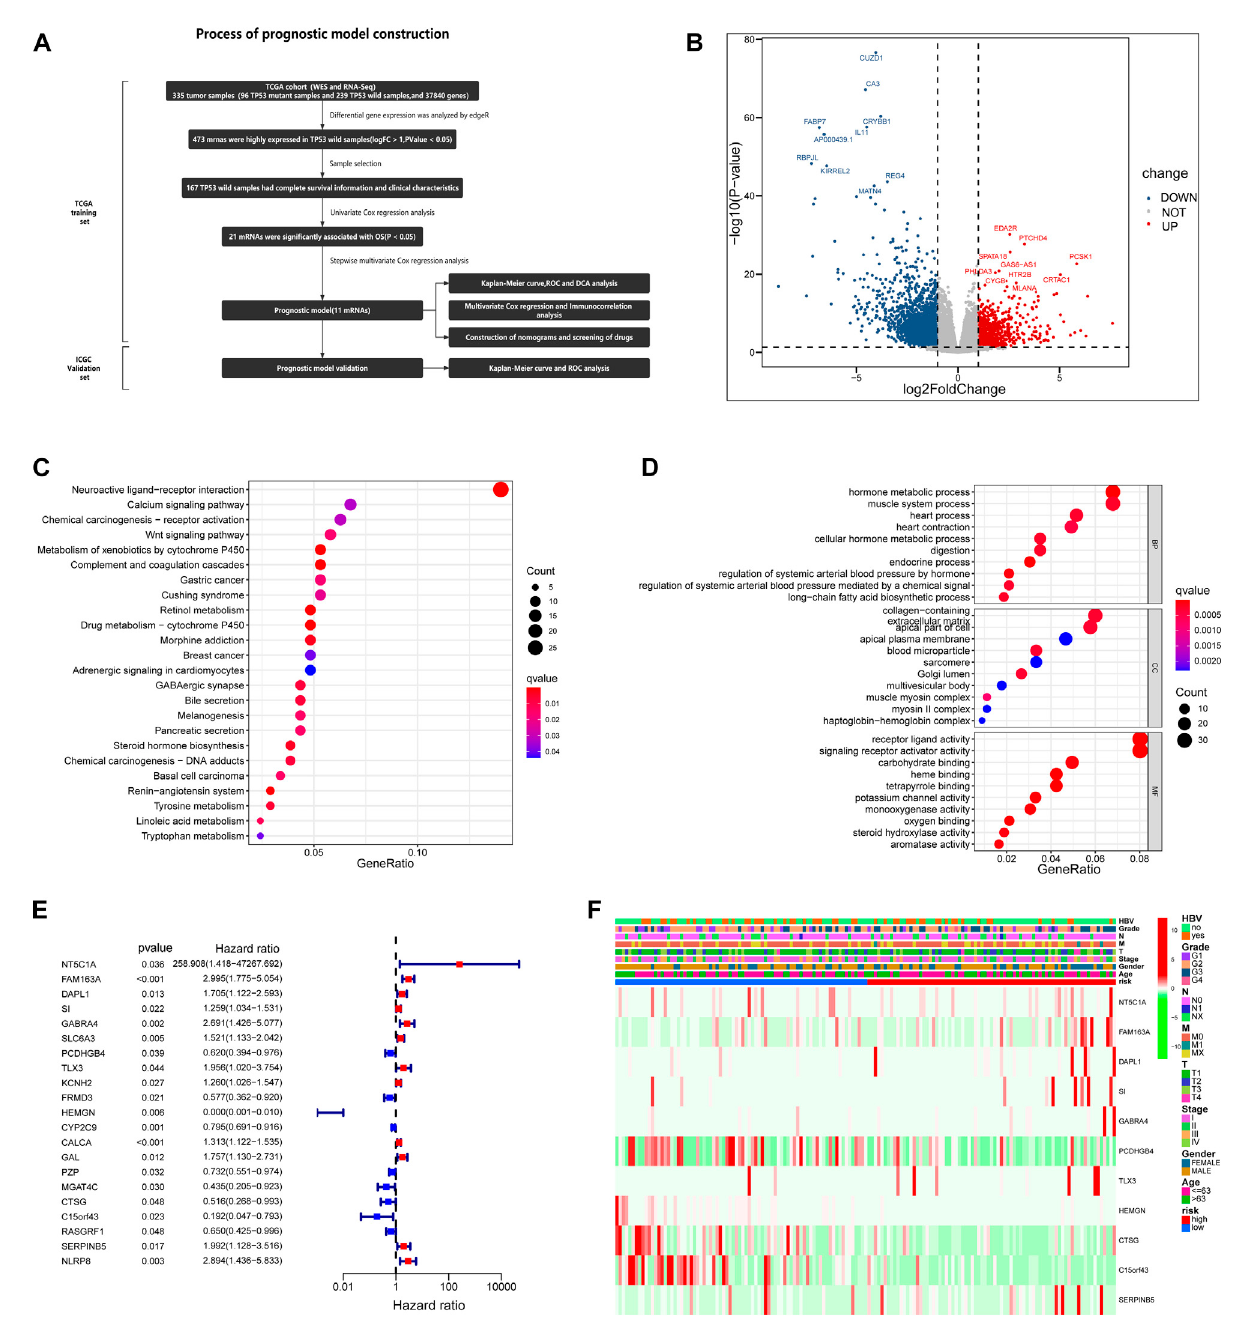
FIGURE 4 Based on TCGA database, the prognostic risk model of HCC patients with TP53 wild type was constructed. (A) A complete process for the development and veri fi cation of prognostic risk models. (B) The volcano map is used to show the differentially expressed genes between TP53 mutant group and wild group. (C) Results of KEGG enrichment of highly expressed genes in TP53 wild group. (D) Results of GO enrichment of highly expressed genes in TP53 wild group. (E) Univariate Cox regression analysis of the relationship between highly expressed genes and OS in TP53 wild group. (F) The differential expression of genes involved in the construction of prognostic risk model in different clinical feature groups and different risk